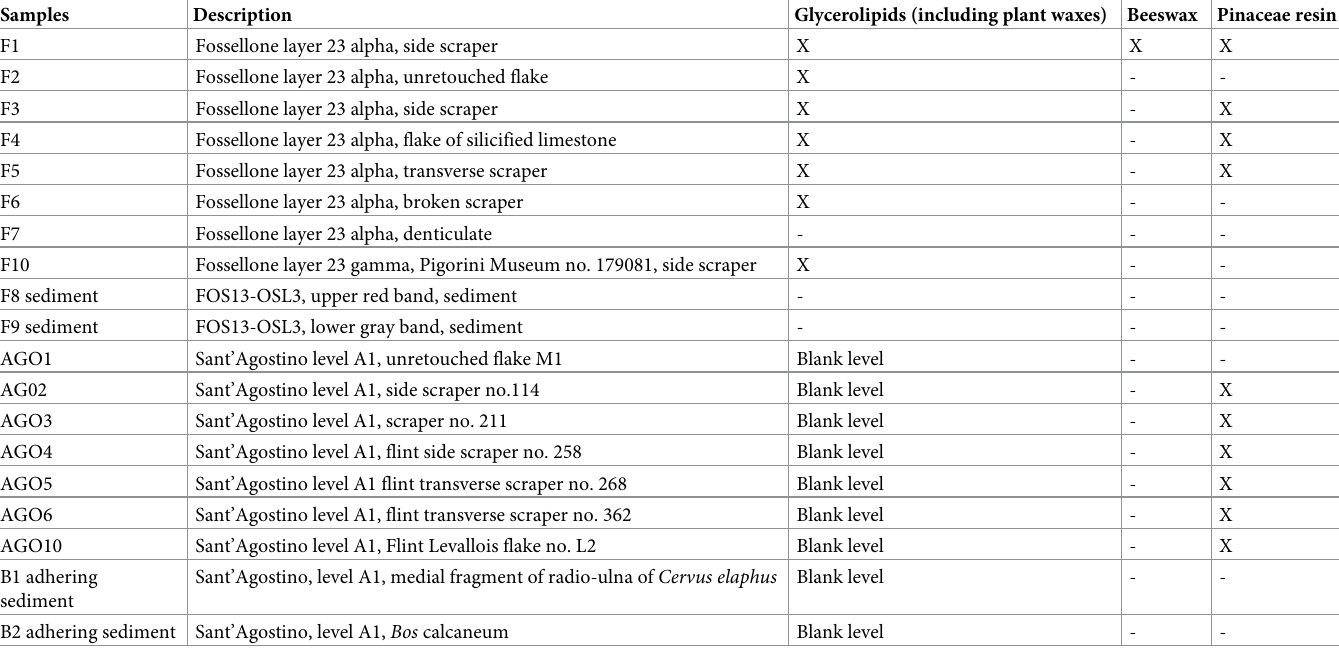
Table 9. Summary of results of the gas-chromatographic